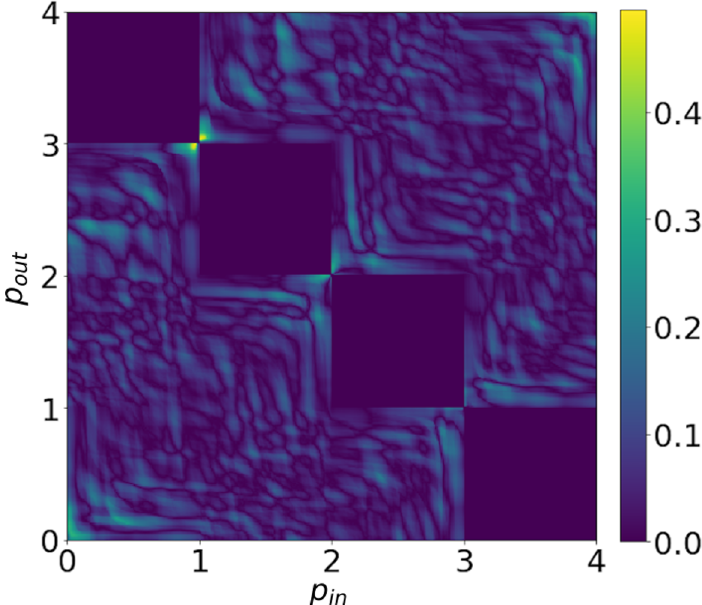
Figure 28 . A heat map of wombling measures | ¯Γ[ C ] | analogous to figures 19, 22 and 25, but for a typical background pseudo-experiment where the point data is generated from the pure-background distribution (2.2) and then a single Lloyd iteration is